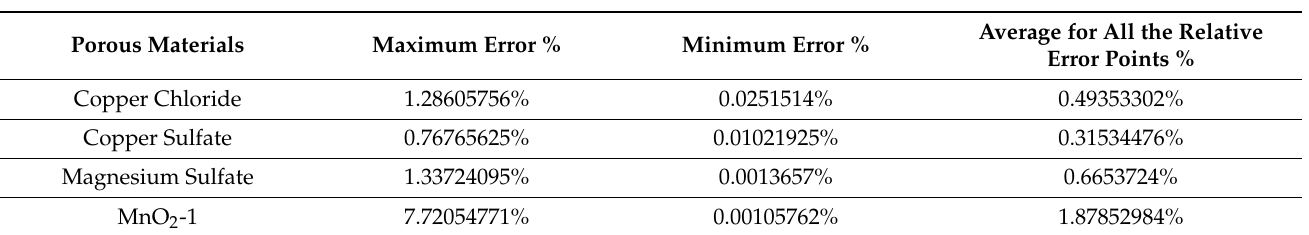
Table 4. Relative error for porous